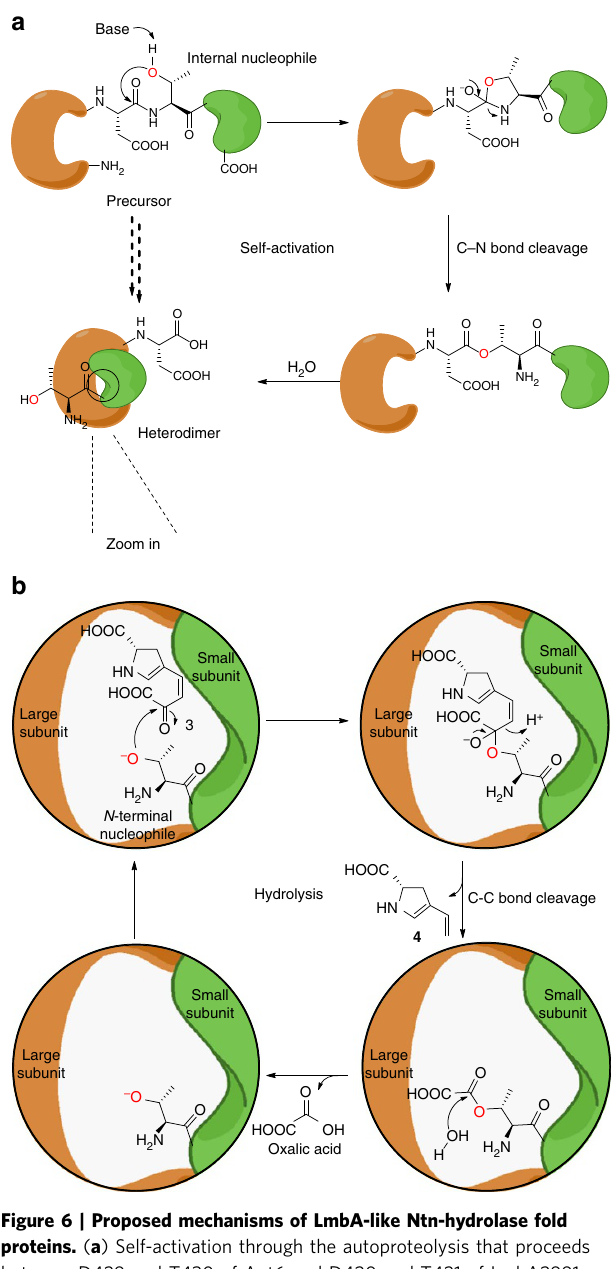
Figure 6 | Proposed mechanisms of LmbA-like Ntn-hydrolase fold proteins. ( a ) Self-activation through the autoproteolysis that proceeds between D429 and T430 of Ant6 and D420 and T421 of LmbA2991, respectively. ( b ) C–C bond cleavage by hydrolysis through the generation of oxalyl-Thr enzyme